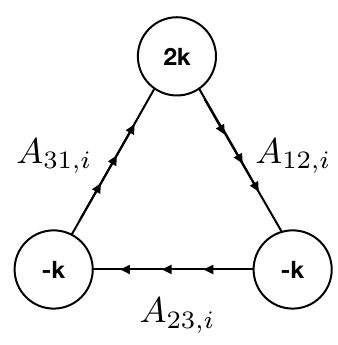
Figure 1 . The quiver diagram for CS theory dual to AdS 4 (cid:2) M 1 ; 1 ; 1